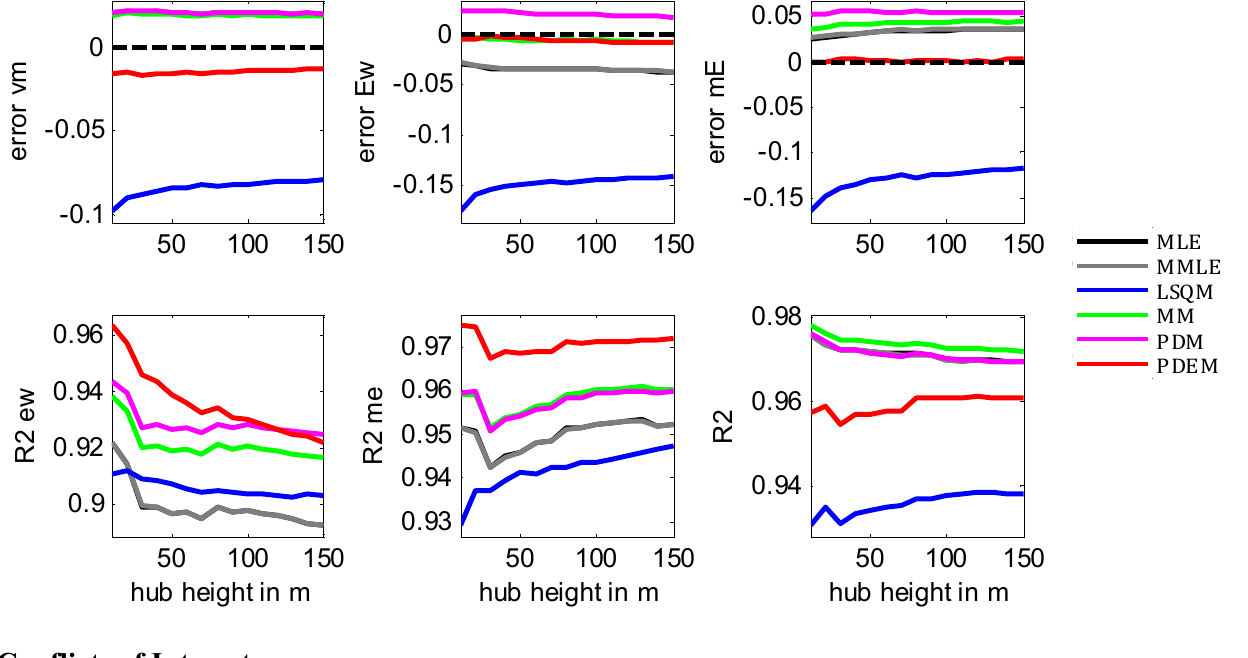
, error , error , R 2 , vm Ew mE ew